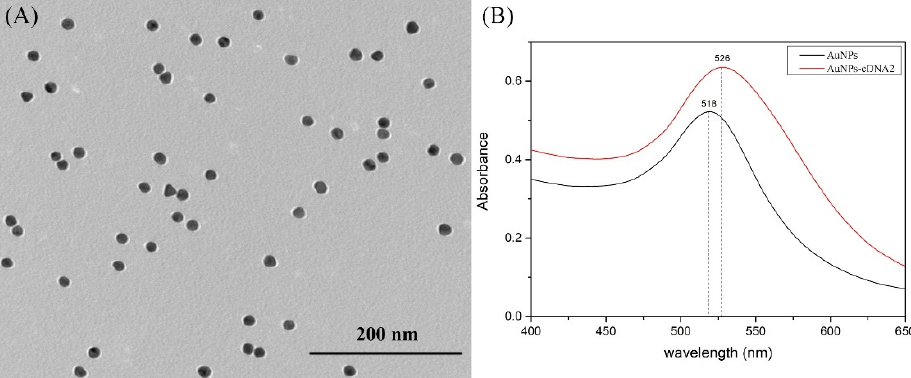
Figure 1. Characterization of colloidal gold. ( A ) The TEM image of AuNPs (Scale bar: 200 nm). ( B ) UV–visible absorption spectra of AuNPs and AuNPs-cDNA2 probe.